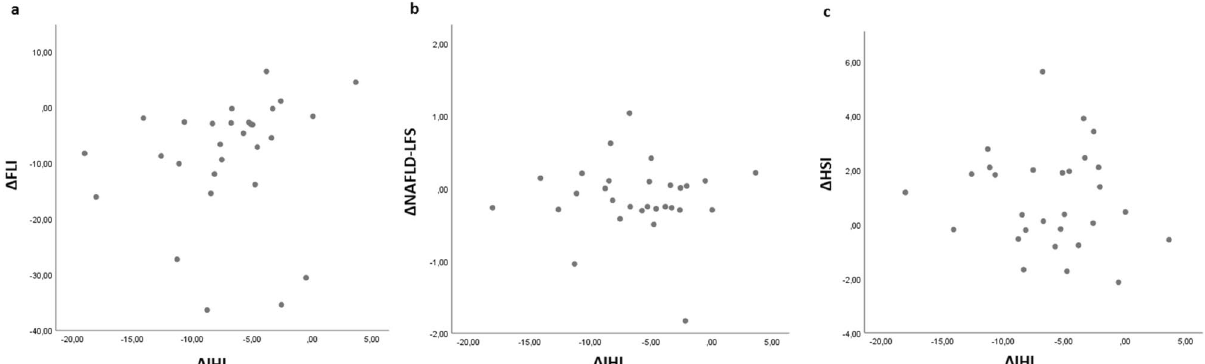
Correlation between change of liver fat content (MR-S) and change of … (n = 31) Body weight (kg) Rho = 0.347, p = 0.056 Waist circumference (cm) Rho = 0.409, p = 0.022 * Fasting insulin (pmol/L) Rho = − 0.026, p = 0.890 Triglycerides (mg/dl) Rho = 0.299, p = 0.103 AST (U/ml) Rho = 0.091, p = 0.626 ALT (U/ml) Rho = 0.200, p = 0.298 AST/ALT ratio Rho = − 0.133, p = 0.490 GGT (U/ml) Rho = 0.219, p = Table 2. Correlation analysis on interventional changes. ALT alanine aminotransferase, AST aspartate aminotransferase, GGT gamma-glutamyltransferase; * p < 0.05; ** p < 0.01; *** p < 0.001.